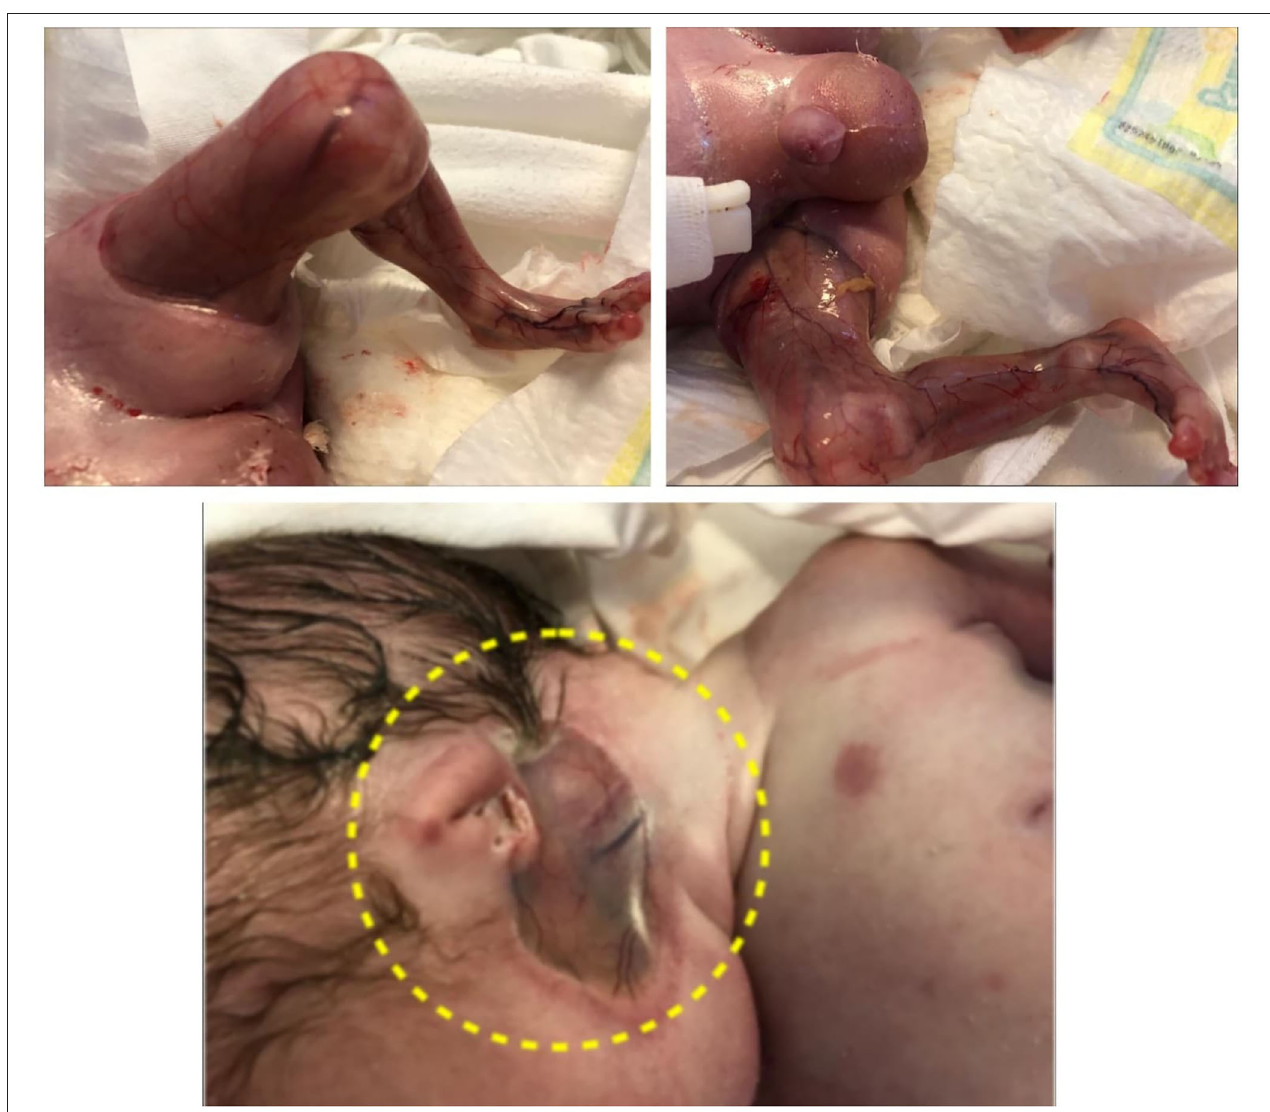
FIGURE 4 | Aplasia cutis congenital of lower limbs, absence of toenail. Outer ears